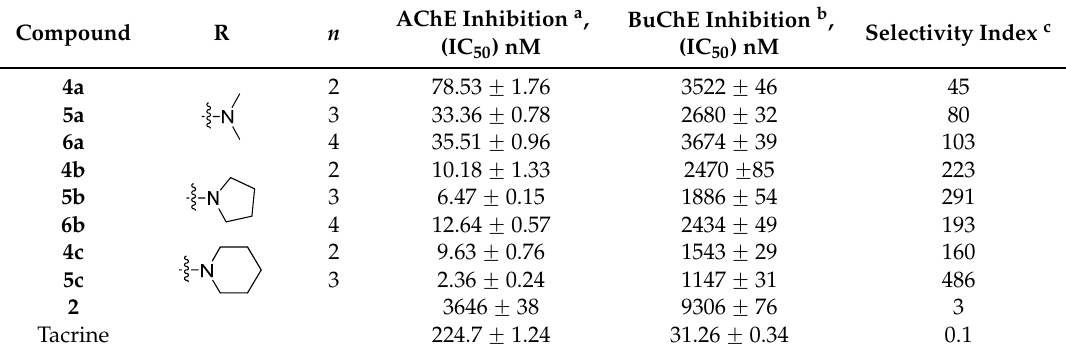
Table 1. In vitro inhibition IC 50 and selectivity index of graveoline analogs 4a – 4c , 5a – 5c and 6a – 6b on Acetylcholinesterase (AChE) and butyrylcholinesterase (BuChE).